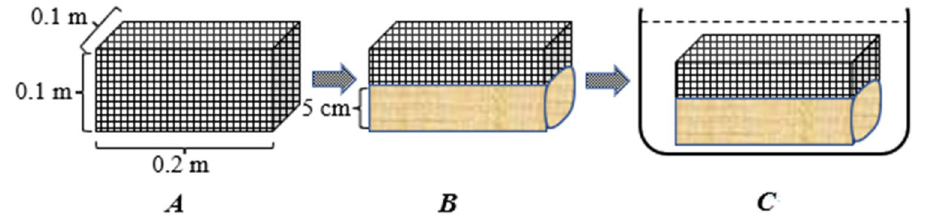
Figure 1. Sketch map of the water-holding capacity experiment ( A is a special diamond mesh cage; B is the schematic of the 5 cm bran; C is the schematic of immersion of cage fitted with organic